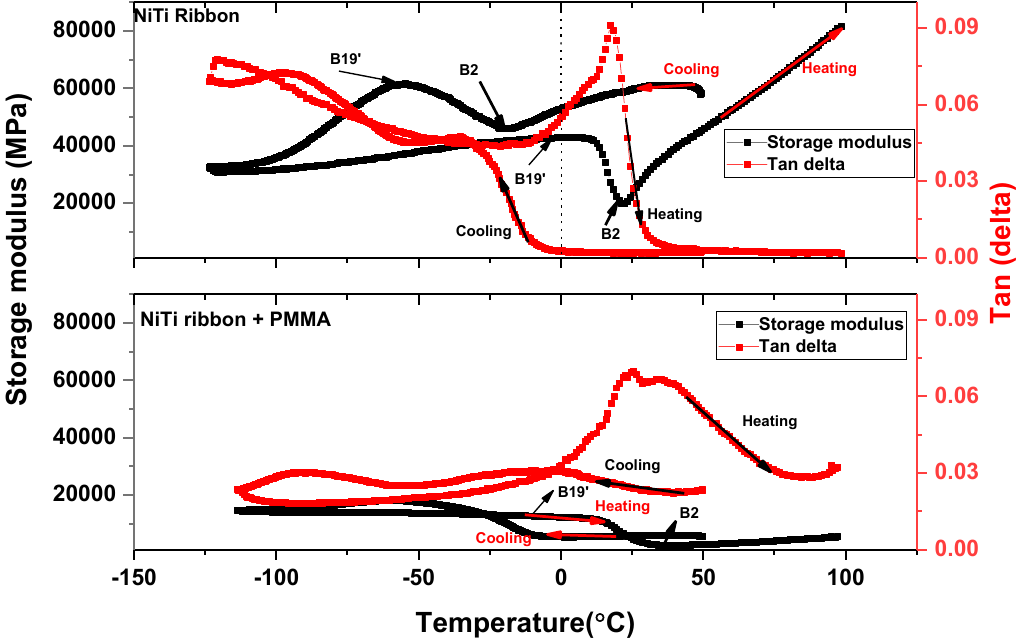
Figure 10. Dynamic mechanical analysis (DMA) response of the Ni-Ti ribbon and PMMA Ni-Ti ribbon composite.